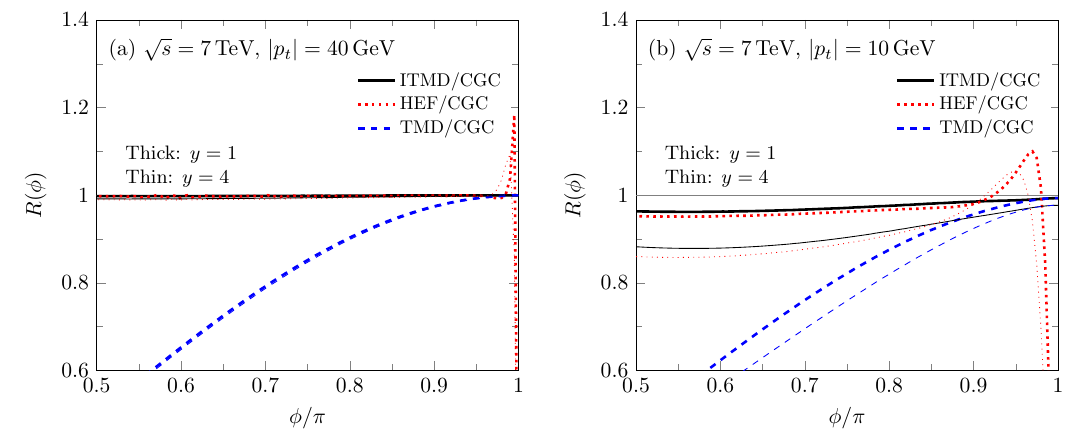
Figure 5 . Ratios of the ITMD to the CGC result for quark dijet production cross-section (ITMD/CGC) are shown in solid black line as a function of the azimuthal angle φ between the jets at (a): | p t | = 40 GeV and (b): | p t | = 10 GeV in p + p collisions at line denotes the results at y = 1 ( y = 4 ). Ratios of HEF/CGC and TMD/CGC are also plotted with red dotted, and blue dashed lines, respectively.